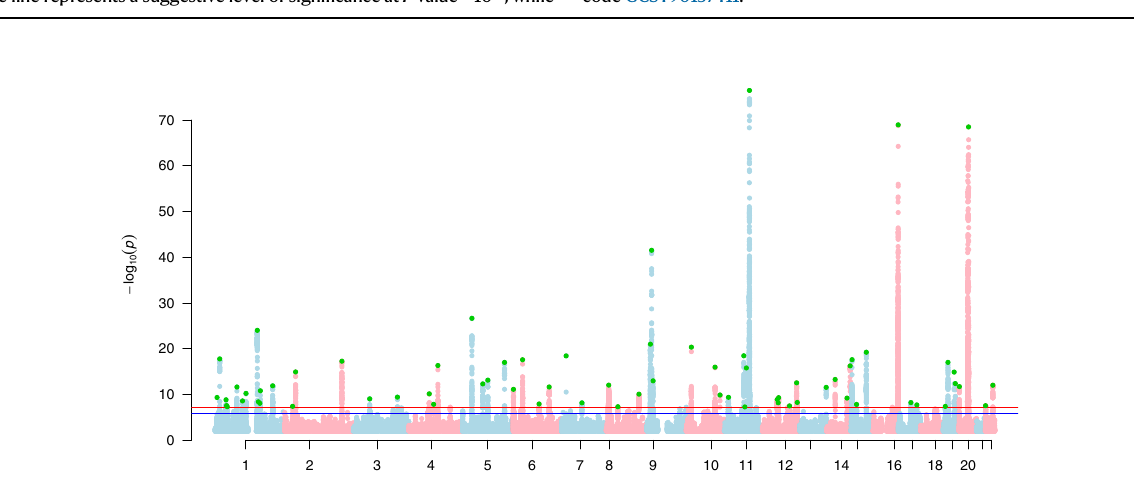
theredonerepresentsthegenome-widelevelofsigni fi cance; P =5×10 − 8 .Thegreen dots represent the 78 genome-wide signi fi cant independent loci for basal cell carcinoma susceptibility (after multiple correction for a million tests; 0.05/ 1,000,000). Only SNPs with a P value <0.01 were included. The source data fi le is provided as the BCC summary statistics in the GWAS Catalogue under accession code GCST90137411.